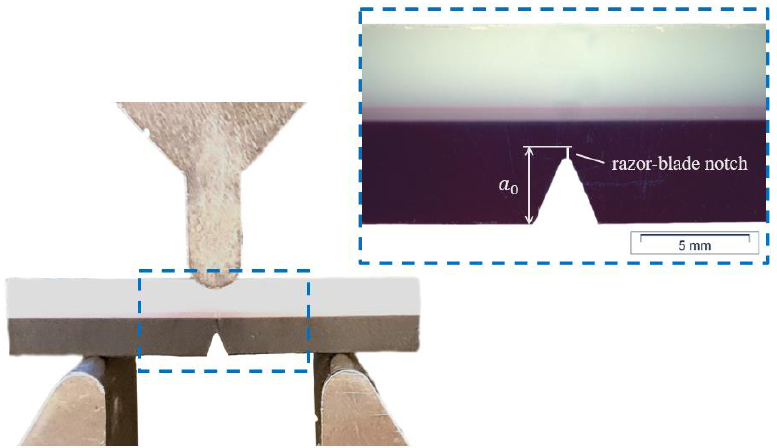
Figure 2. Photograph of a multi-layer SENB specimen with two outer HDPE layers in white and black, and the middle barrier layer consisting of EVOH in pink (before side-grooving). The used three-point bending setup with a support length of 36 mm is also shown.